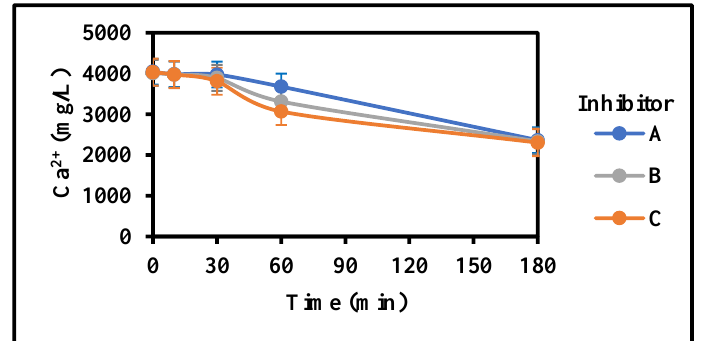
Figure 6. Comparison of various inhibitors on the rate of gypsum crystallization with initial mixing (4000 mg/L CaSO 4 (as Ca), 0 g/L gypsum seed, 4 g/L Fe 3+ , 100 mg/L Inh, 25 °C, stirring rate: 200 rpm; Stirring time (min): 180/180; pH 3.5).